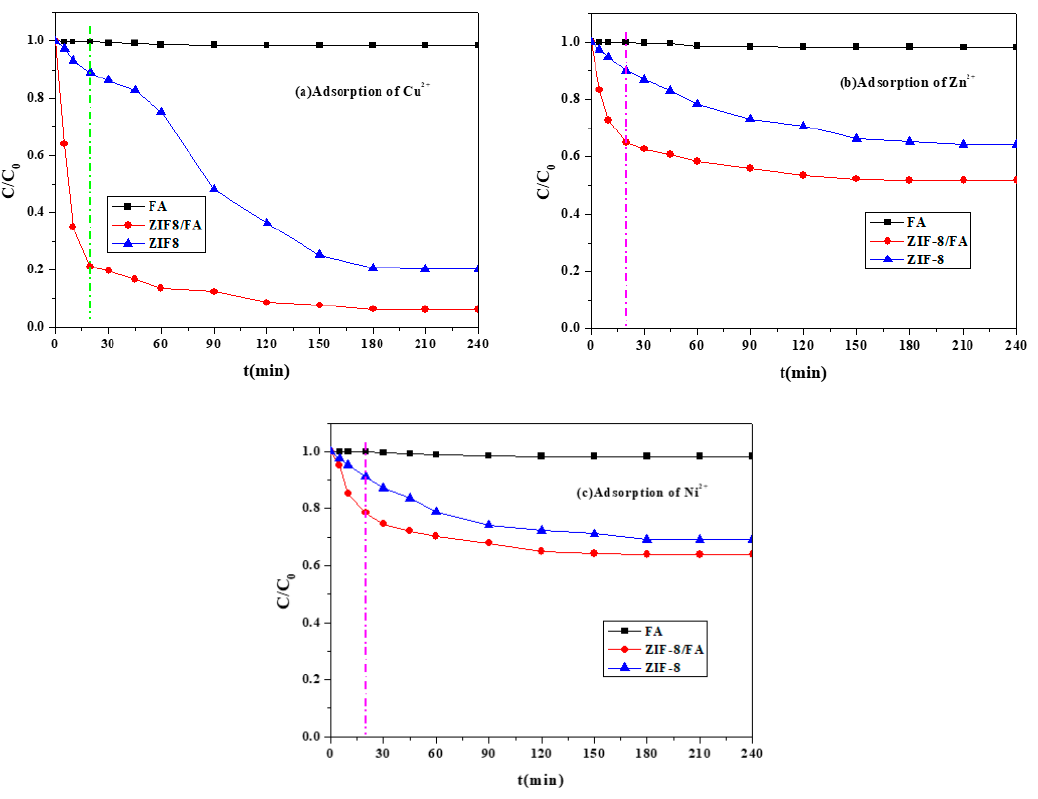
Figure 7. Adsorption of Cu 2+ , Zn 2+ , and Ni 2+ using different samples (Adsorbent = 50 mg, ( a ) Cu 2+ = 50 mL of 100 mg/L, ( b ) Zn 2+ = 50 mL of 100 mg/L, ( c ) Ni 2+ = 50 mL of 100 mg/L).